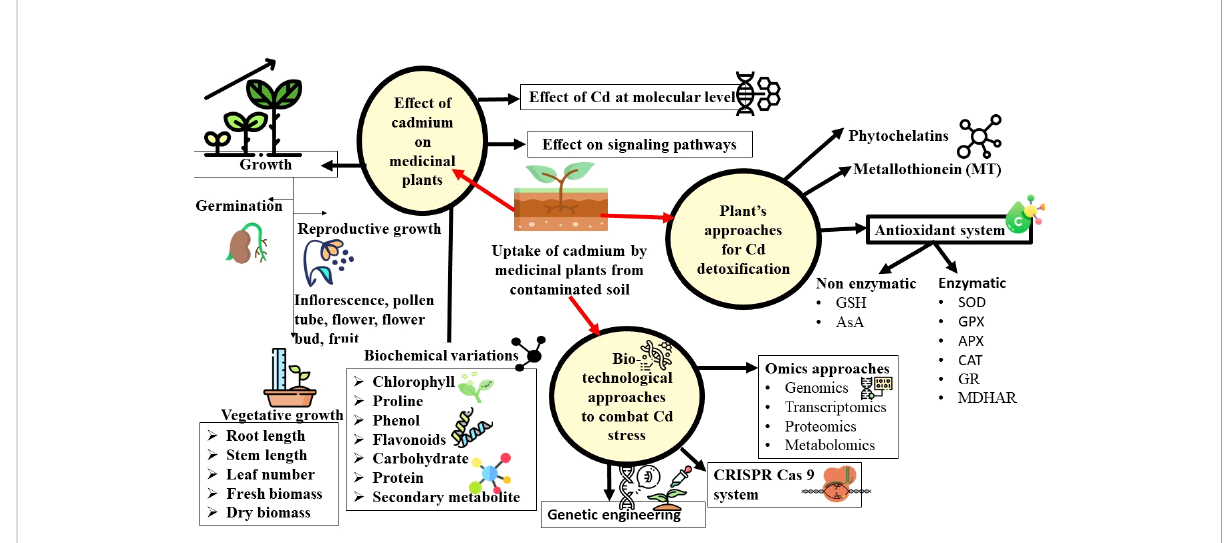
FIGURE 3 Schematic illustration of the effect of cadmium on morphological, physiological, and biochemical characteristics of medicinal plants and biotechnological and omics approaches to alleviate the cadmium